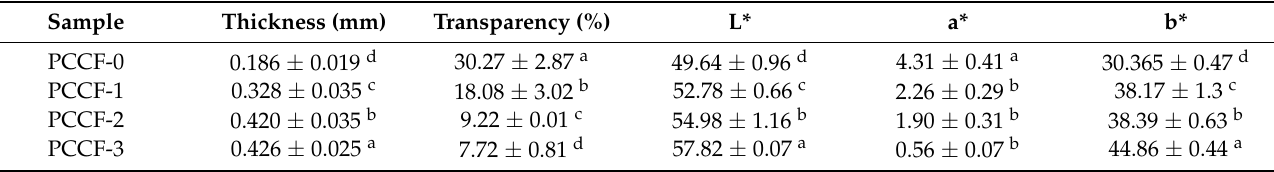
Table 1. The physical and optical characterization of